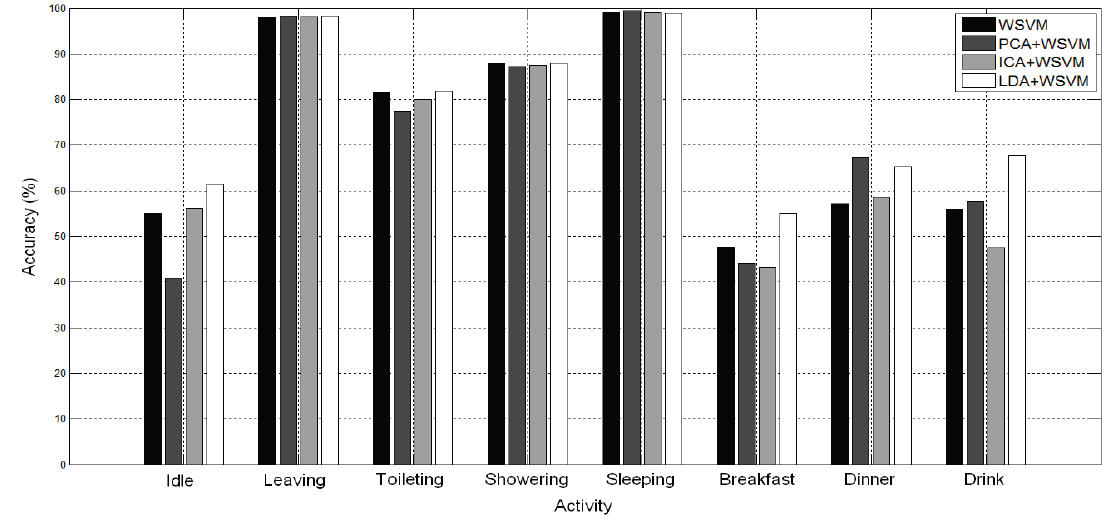
Figure 4. Accuracy for each activity on TK26M dataset.